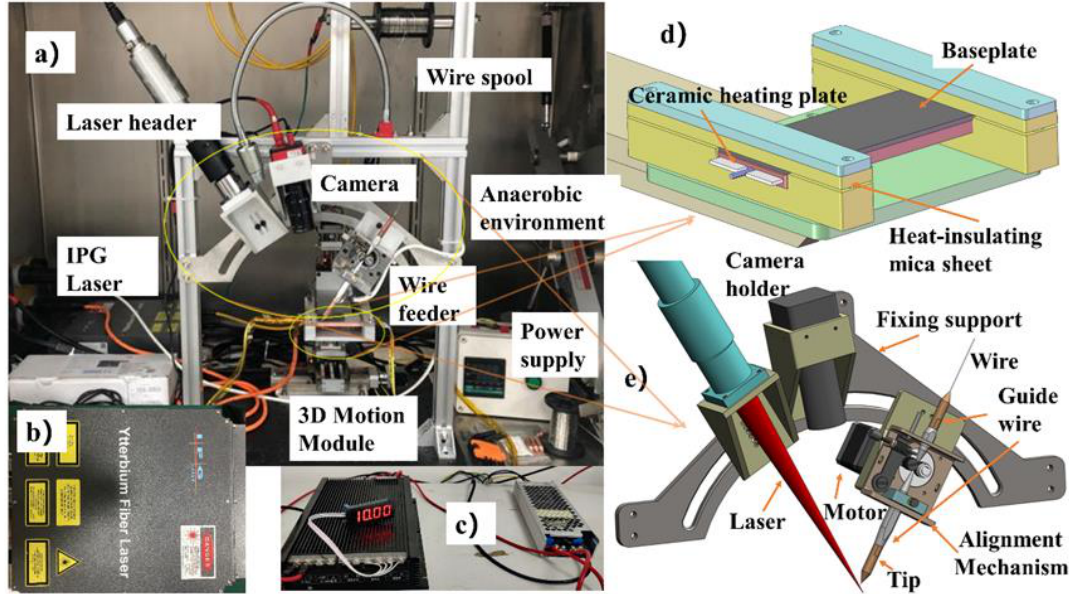
Figure 2. Details of the LJWF-DMD AM system. ( a ) Overview of test equipment. ( b ) Laser device. ( c ) Joule heating power supply. ( d ) Baseplate temperature control system. ( e ) Laser-wire alignment adjustment mechanism.